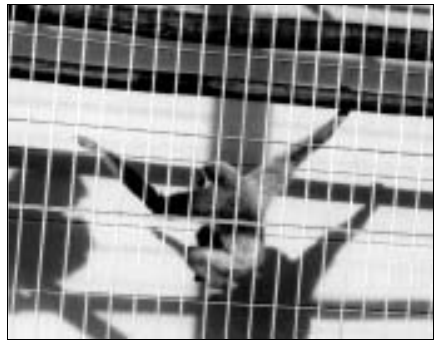
Figure 3 Brachiation of the white-handed